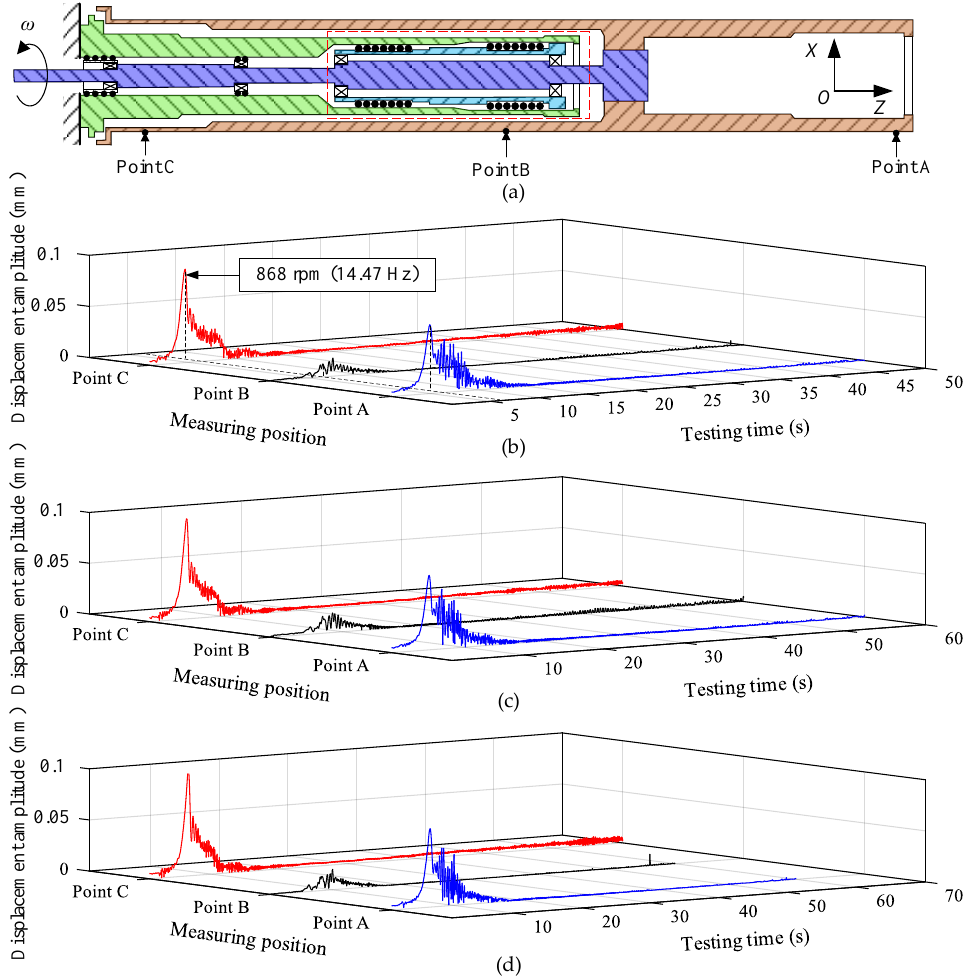
Figure 12. Testing results of the winding rotor under different speed-up times ( a )Measuring points on the winding rotor; ( b ) speed-up time is 50 s; ( c ) speed-up time is 60 s; ( d ) speed-up time is 70 s.